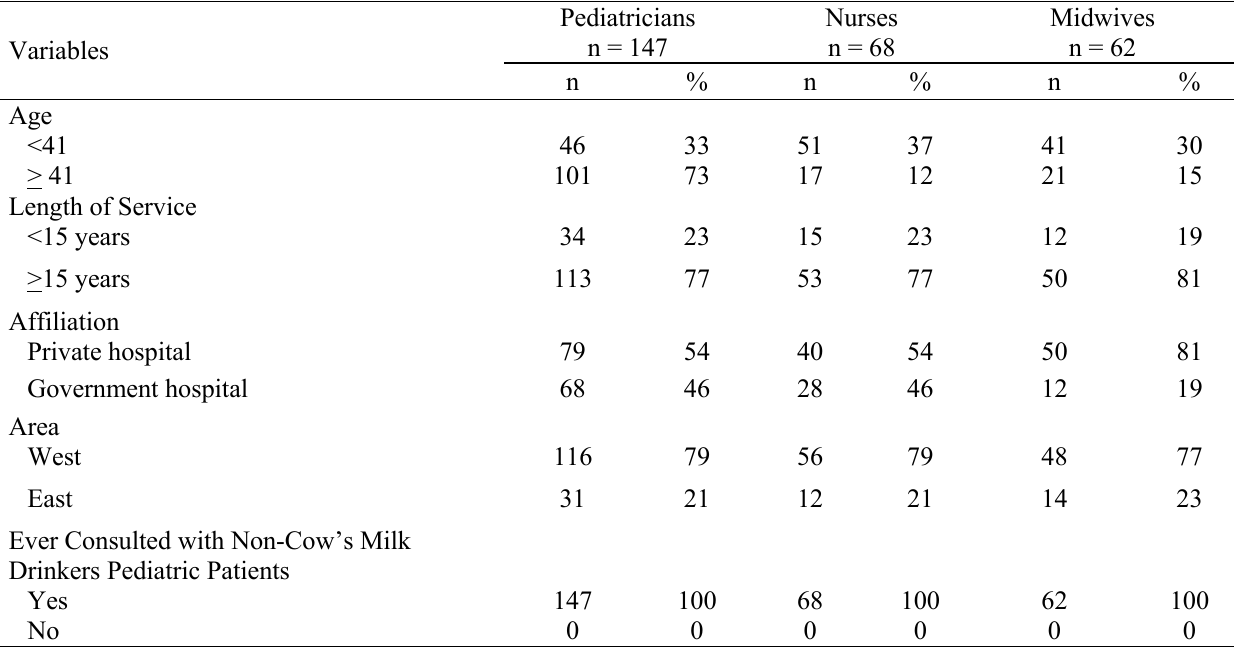
Table 1. Demographic characteristic of respondents